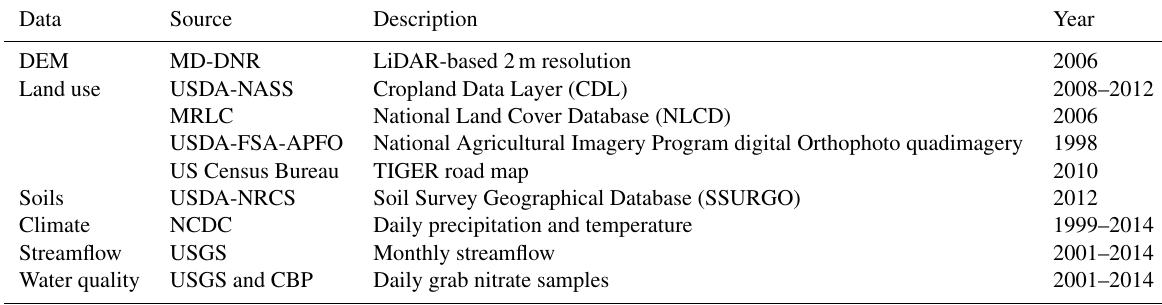
Table 2. List of the SWAT model input data.